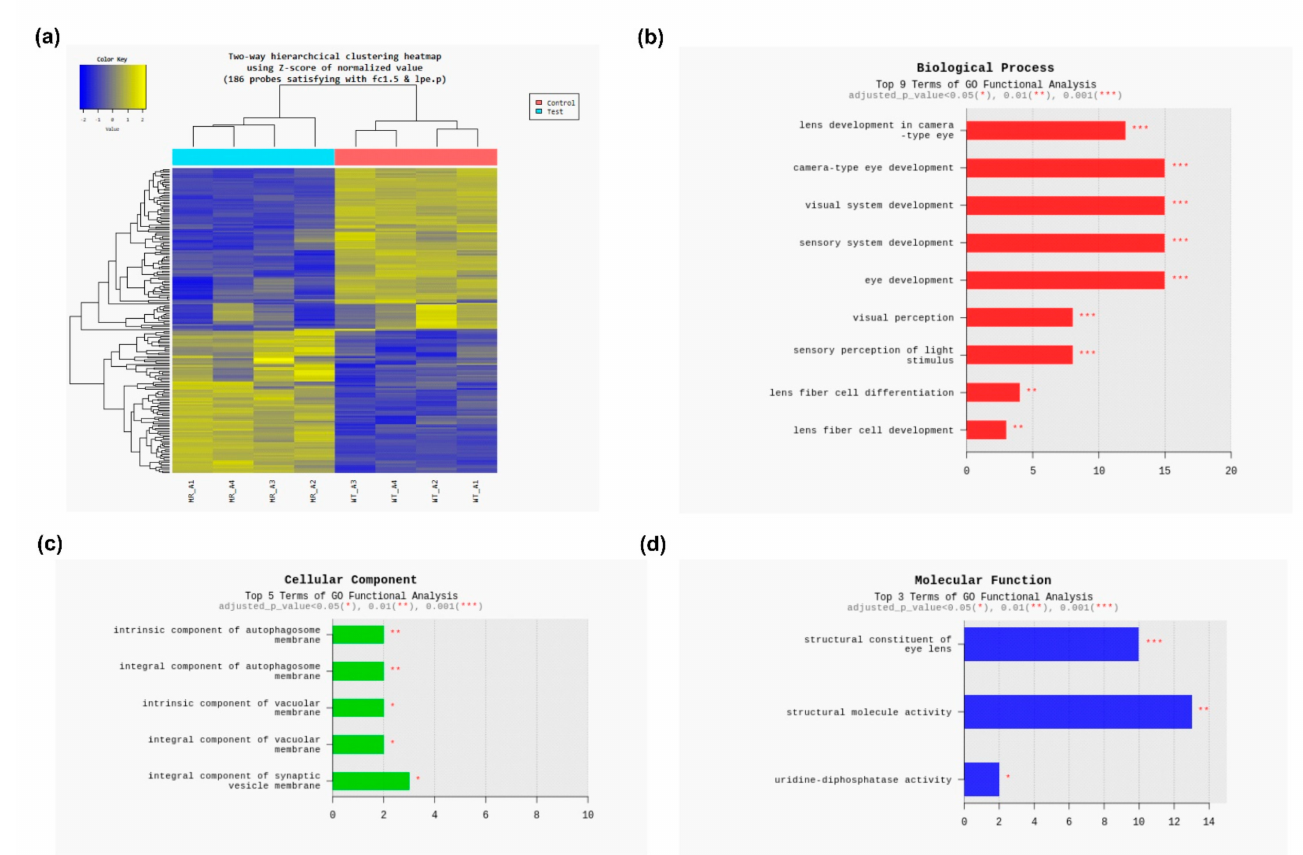
Figure 2. Microarray data analyses. ( a ) Cluster analysis. ( b ) GO analysis (biological process). ( c ) GO analysis (cellular component). ( d ) GO analysis (molecular function). Test, Mrp4 -null mice; control, wild-type mice; MR, Mrp4 -null mice; WT, wild-type mice; fc, fold change; lpe, local pooled error; GO, gene